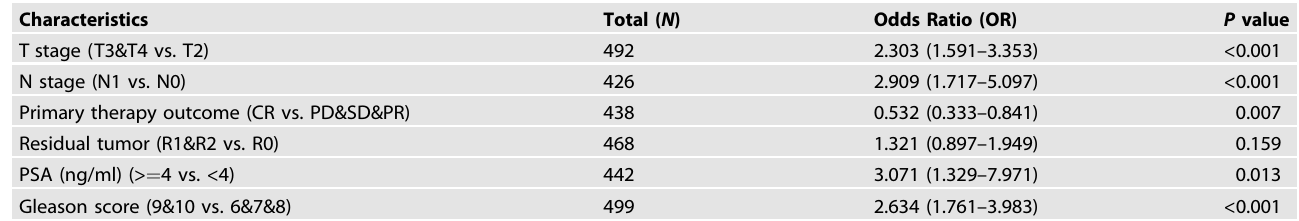
Table 2. DLEU2 expression associated with clinical pathological variables (logistic